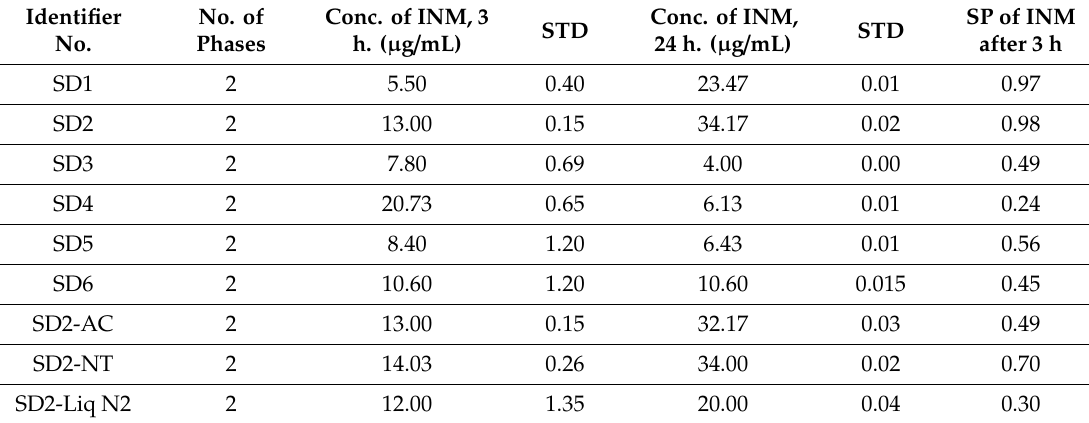
Table 10. Comparison of the aqueous solubility of INM from various quaternary and ternary